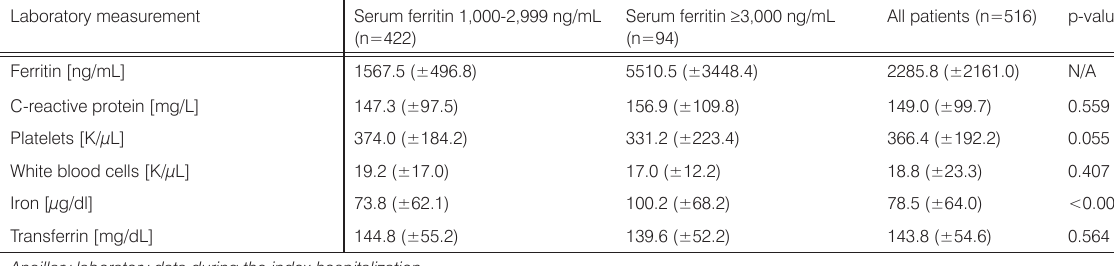
Table 2. Baseline Laboratory